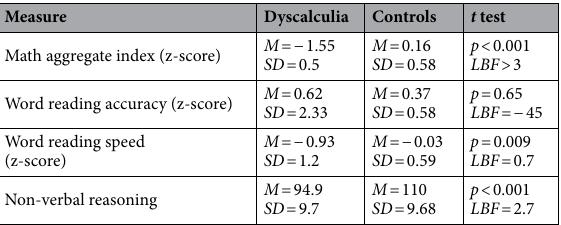
Table 1. Descriptive statistics of scores obtained in the neuropsychological tests. Independent samples t tests with associated two-tailed p-values and Log10 Bayes Factors ( LBF ).